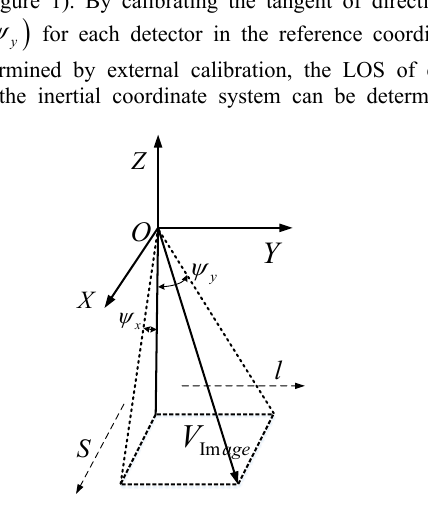
Figure 1. Directional angle model of